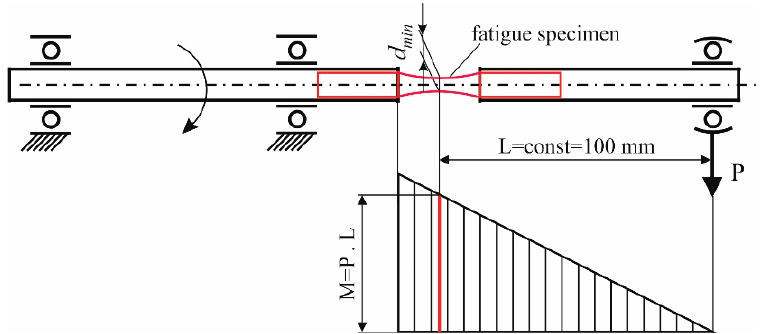
Figure 2. Rotating cantilever bending fatigue test scheme.